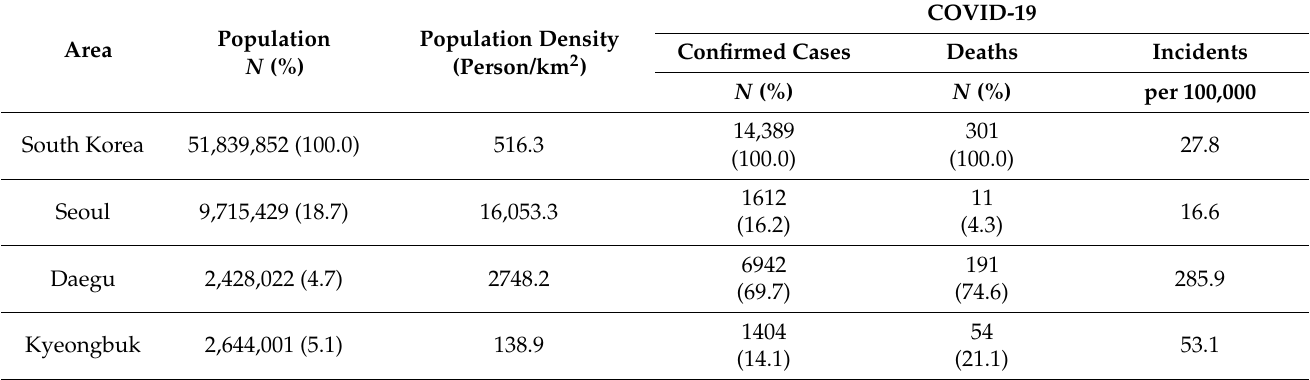
Table 1. Conditions of the study area as of 3 August 2020 (start of the study period). Population Population Area N (%)